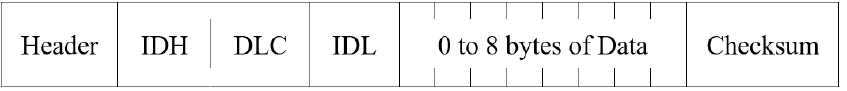
Figure 4. Frame format for the data link layer (DLL).